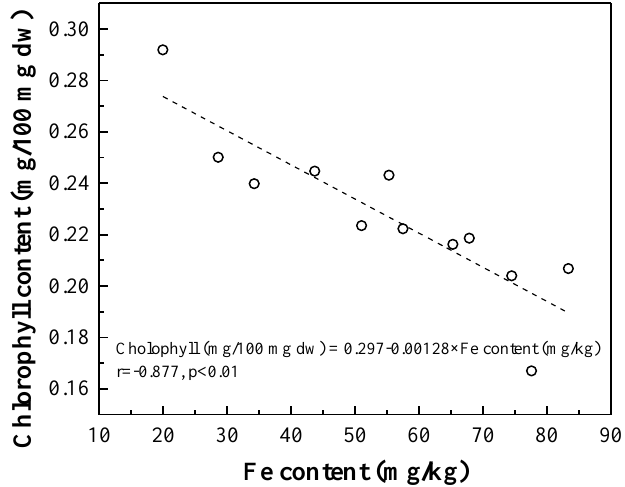
Figure 2. Chlorophyll content vs. Fe content at the fruit set stage.